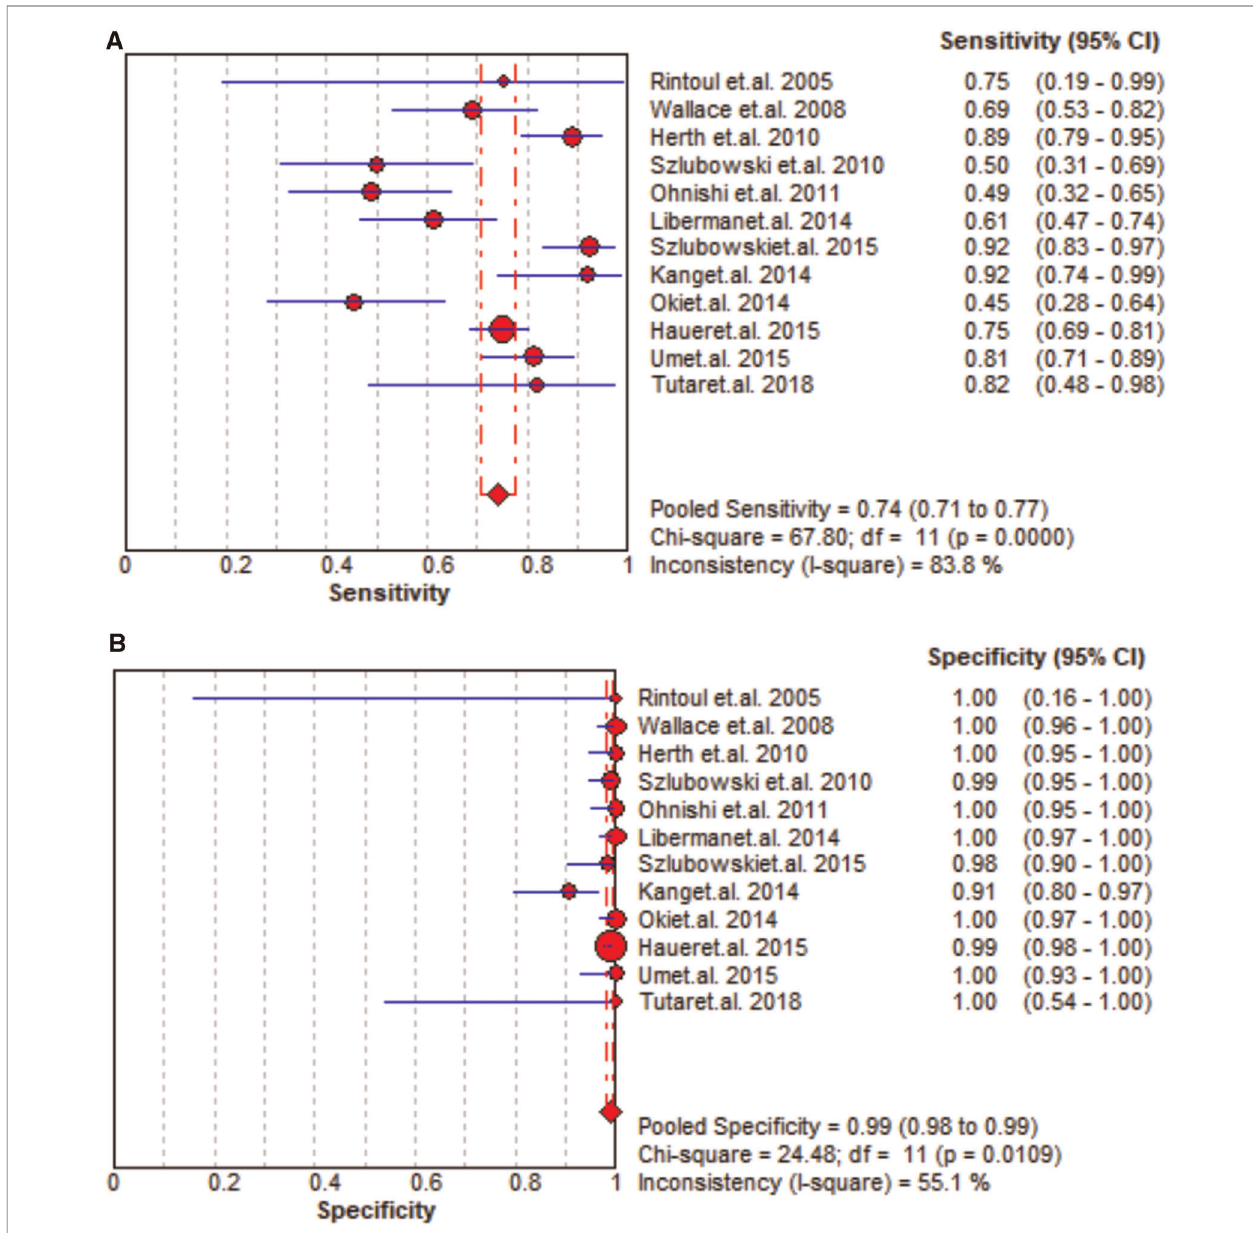
FIGURE 3 | Summary of pooled sensitivity and speci fi city of